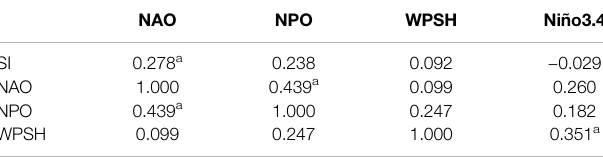
TABLE 1 | Correlation coef fi cients between the snowfall index (SI) and climate